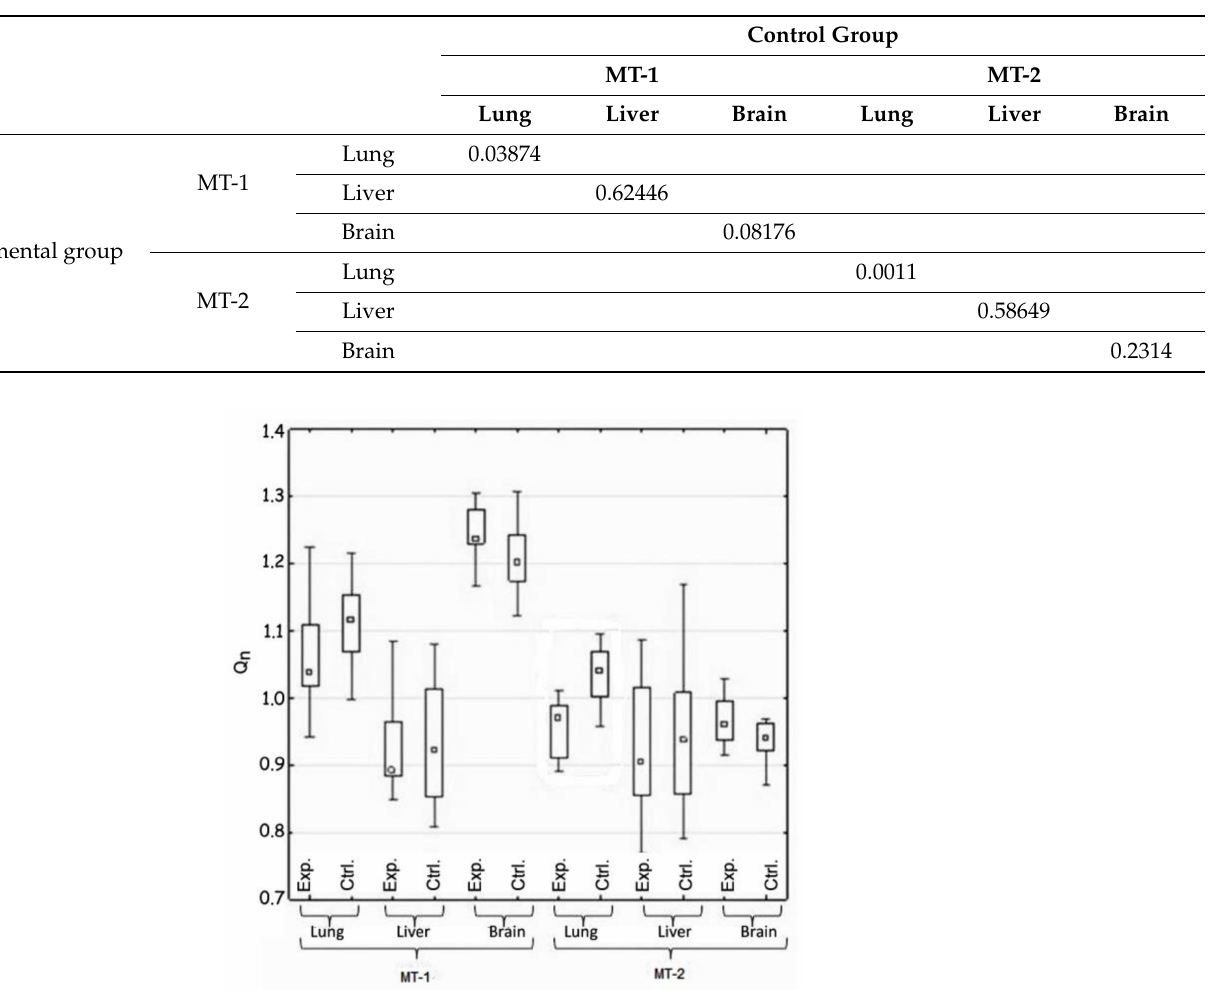
Table 2. The Result of the Mann-Whitney U Test for the Significance of Differences between the Control and Experimental Groups in the Expression of MT1 and MT2 Genes (H1) at p < 0.01.